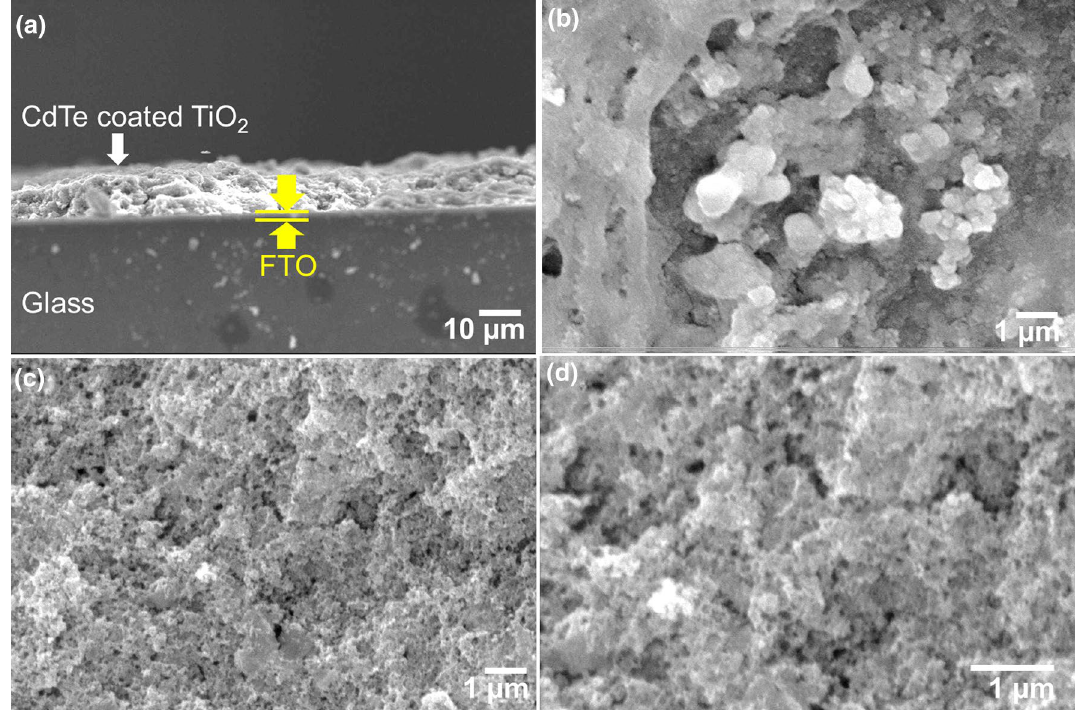
morphologies of CdTe-coated TiO 2 at the magnifications of × 10,000 and × 20,000 exhibit the resulting porous